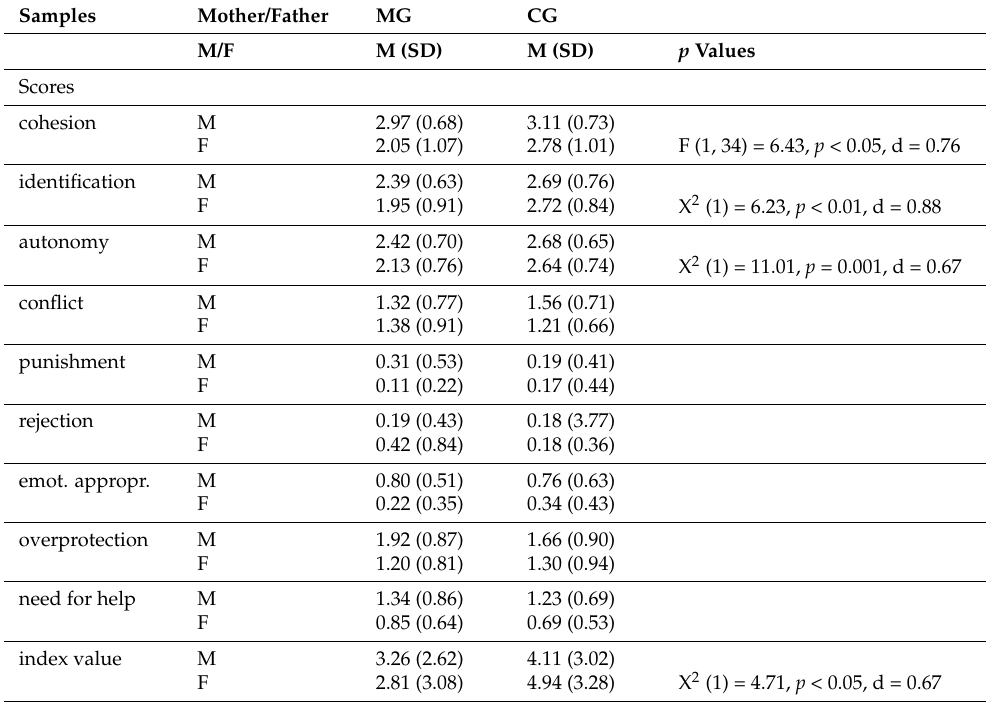
Table 3. Results of the “Parental-Representation-Screening-Questionnaire” for the group with selec- tive mutism (MG) compared with the control group